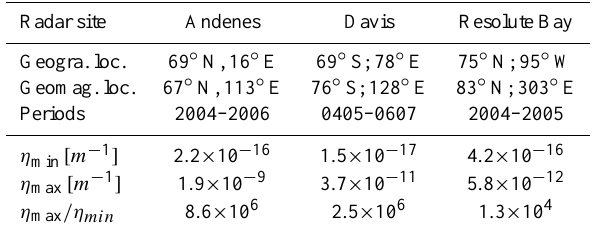
Table 2. Minimum detectable and maximum detected volume radar reflectivity during PMSE observations at Andenes, Davis and Res- olute